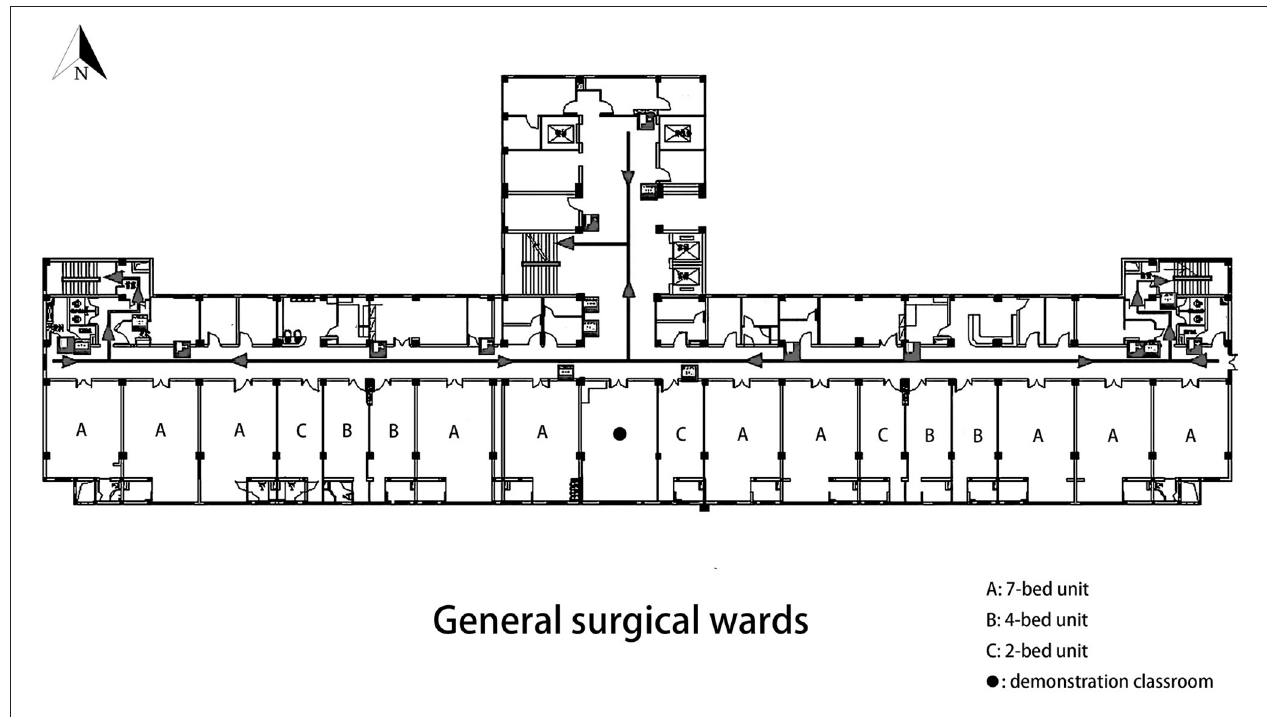
FIGURE 1 | Layouts of the patient units in the general surgical